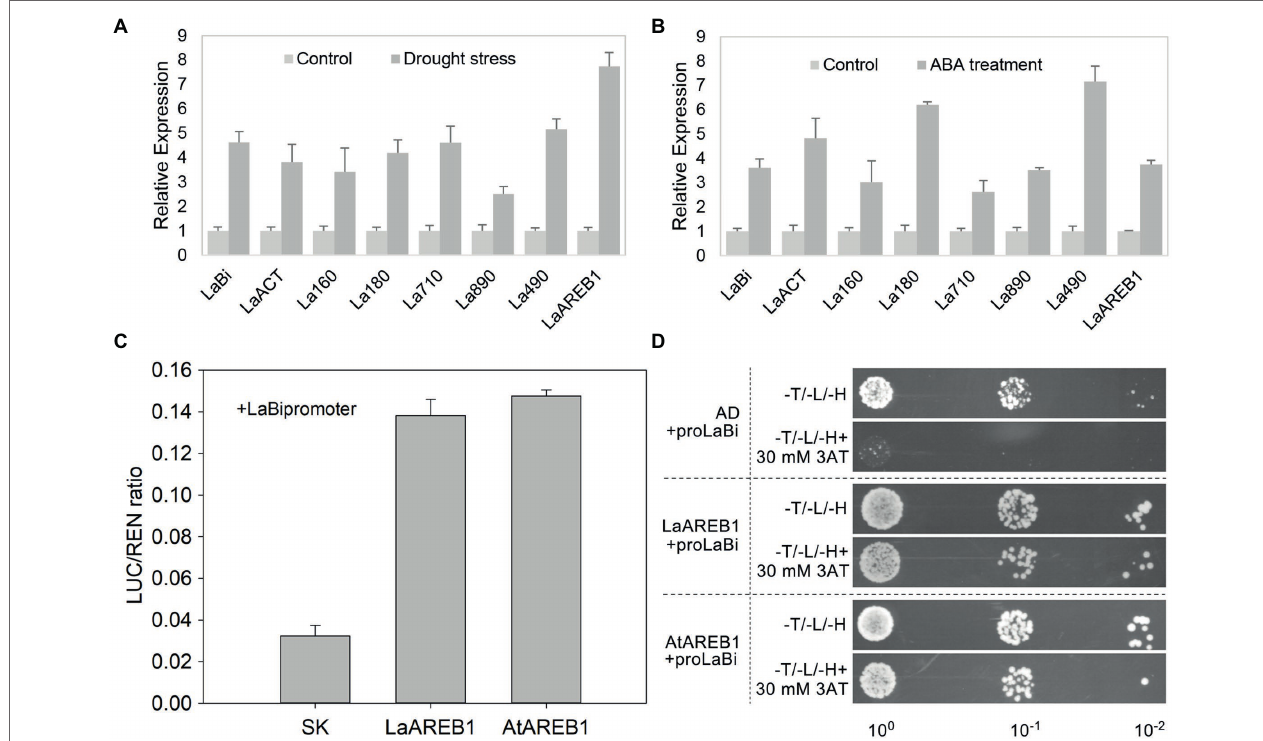
FIGURE 5 | Stress-activated cucurbitacin biosynthesis genes. (A) Expression of Bi , ACT , and CYP450s after drought stress. (B) Expression of Bi , ACT , and CYP450s after ABA treatment. (C) Yeast one-hybrid analysis of the interactions between the LaAREB1 and AtAREB1 proteins and the LaBi promoters. (D) Dual- Luciferase reporter assays show the interactions between LaAREB1 and AtAREB1 proteins and the LaBi